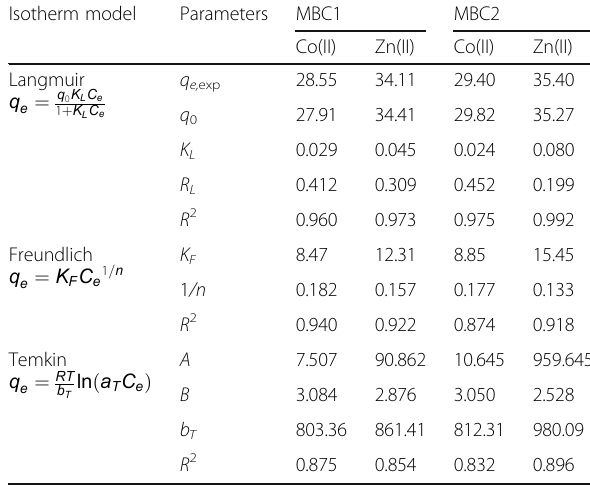
Table 3 Adsorption isotherm parameters and correlation